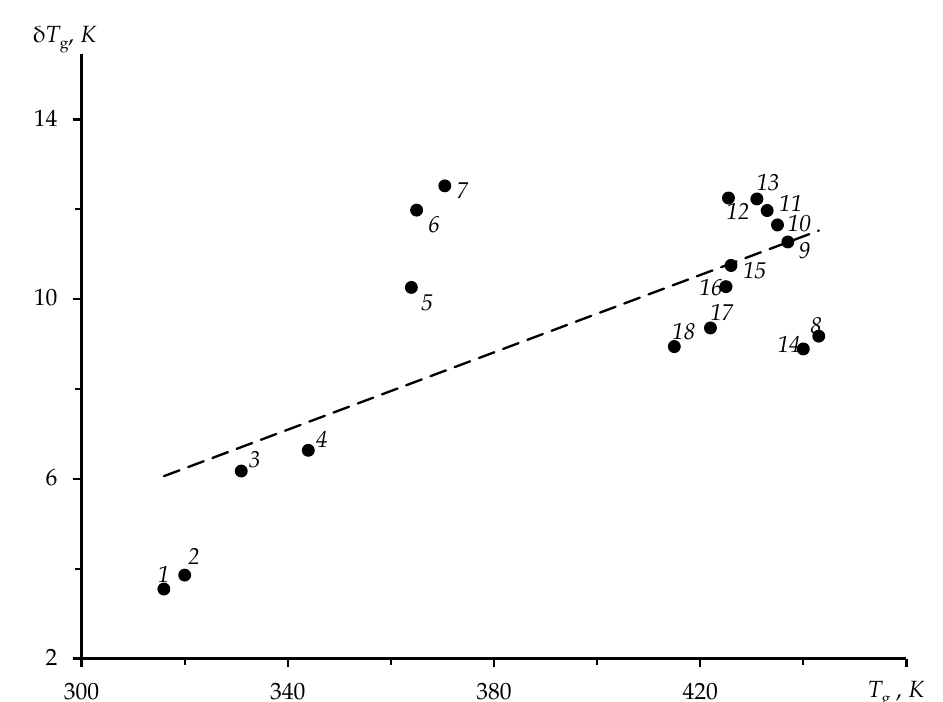
Figure 4. Correlation between δ T g and T g for As-Se glasses. The point numbers correspond to the glass order numbers in Table 1.